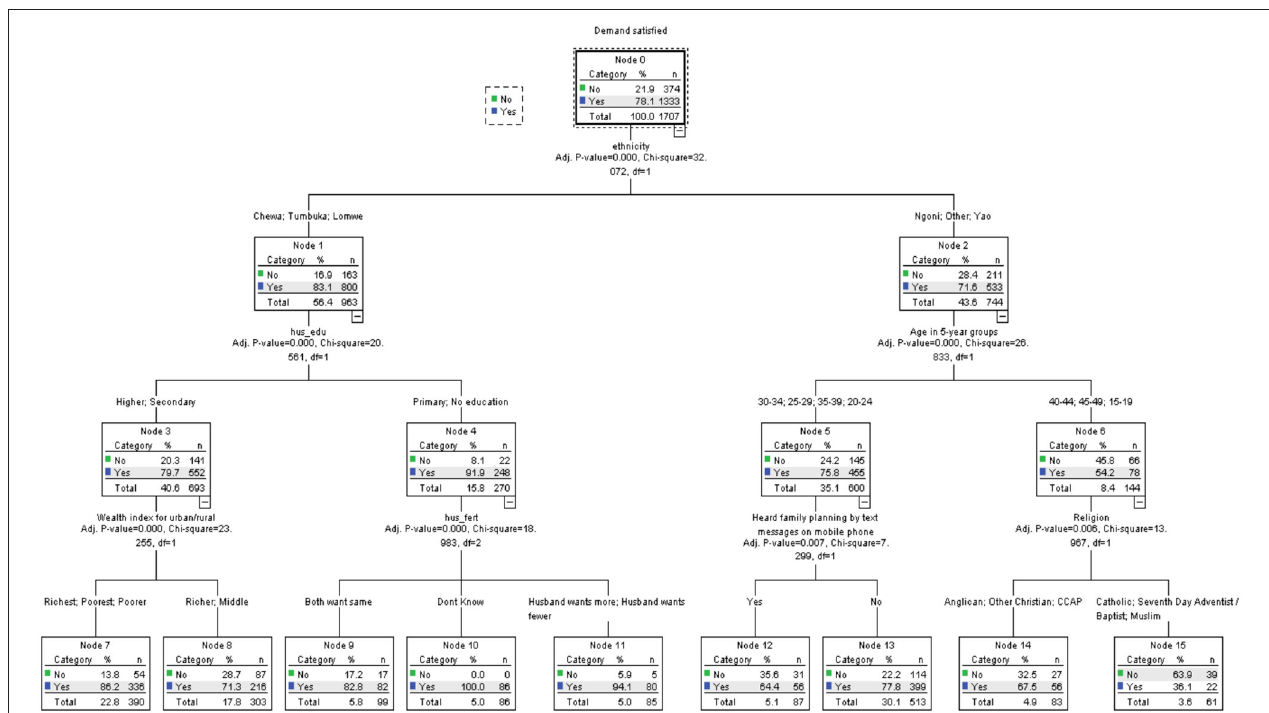
FIGURE 2 | Decision tree diagram for married women in urban areas with demand for modern methods in